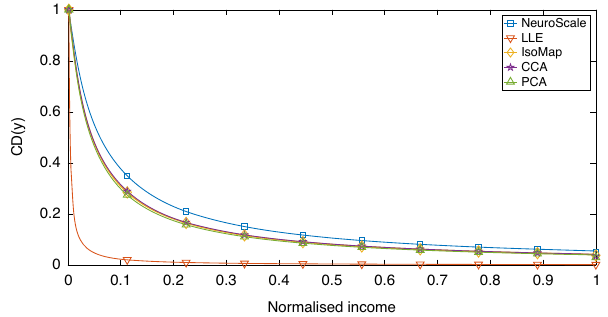
Fig. 2 Variation of the consumption deprivation function against income. Plots of CD ( y ) for the dimension reduced models. As expected, the deprivation drops as income increases up to a saturation